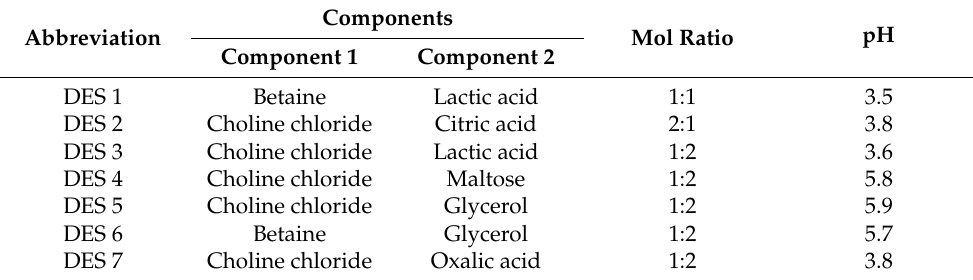
Table 1. Composition of